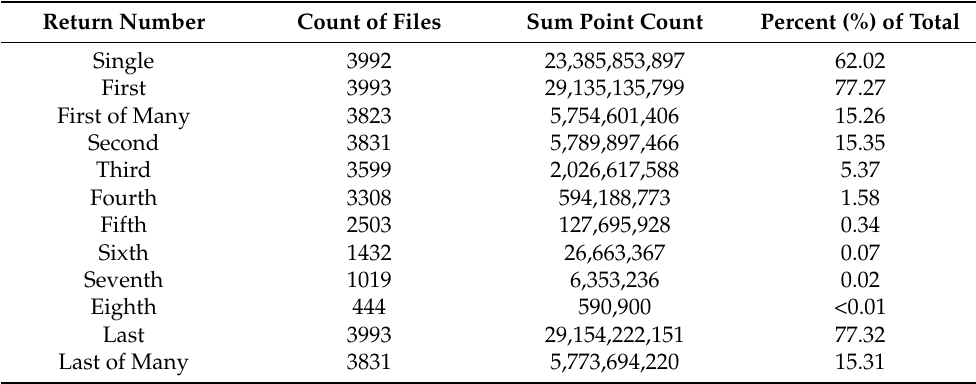
Table 4. Composition of returns from complete random sample